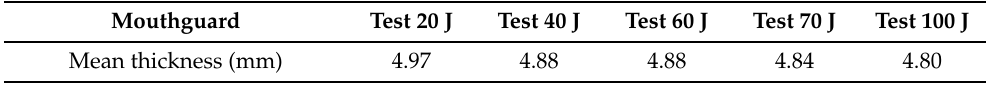
Table 3. Measured mean thickness for each